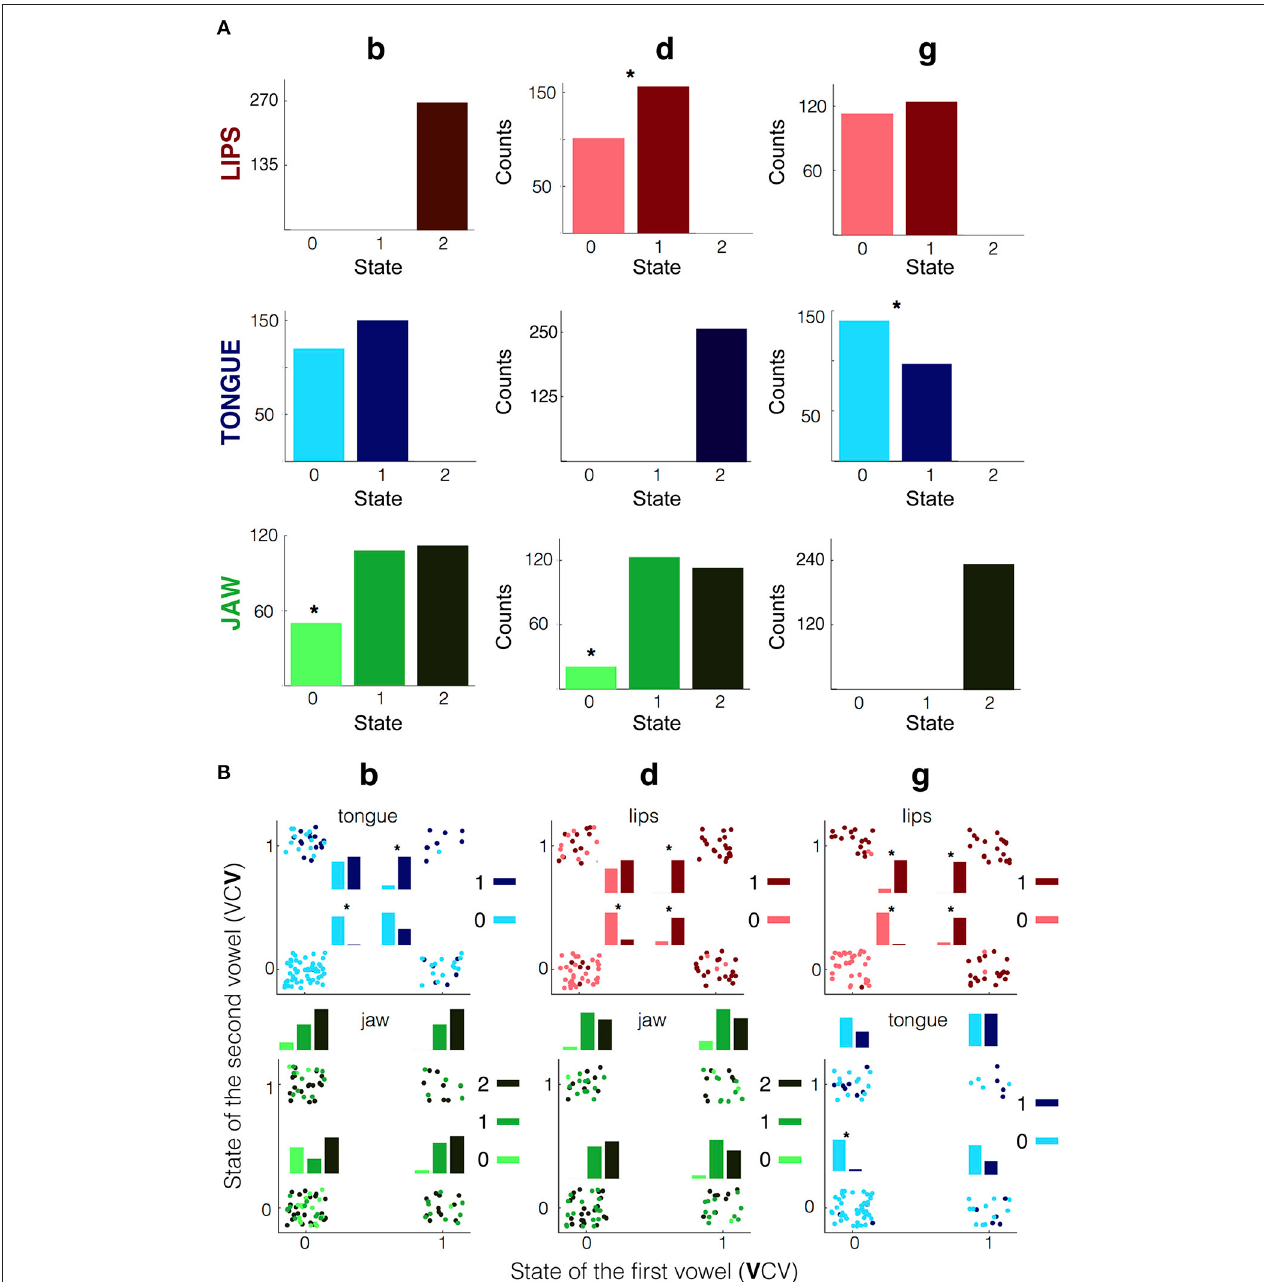
FIGURE 5 | Occupation of the free coordinates. (A) Counts of occurrence of each state, for the complete pool of sessions and participants using the intra-subject and intra-session thresholds for the discretization. Just the correctly decoded VCVs were kept for this analysis. Columns represent the different consonants (/ b /, / d / and / g /) and rows the articulators (jaw, tongue and lips). Asterisks indicate significant difference between states ( p < 0.01 binomial test). (B) Occupation levels of the free coordinates as a function of the surrounding vowels. Each column represents a consonant and the rows its corresponding free states. For each panel the y -axis defines the state of the incoming vowel and the x-axis the state of the previous one. Within each panel, each dot represents a corrected decoded consonant, the darkness of the dot its corresponding state, and its location indicates the pre and post vowel’s state in the corresponding articulator. Also, histograms are displayed for each combination of states of pre and post vowel. Asterisks indicate a significant difference between states ( p < 0.001).